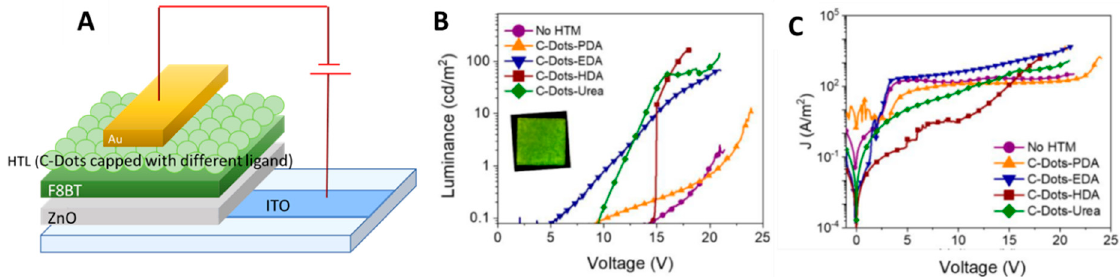
Figure 22. ( A ) Device architecture, ( B ) luminance vs. applied bias (the inset shows a picture of a working device), and ( C ) current density versus applied bias for the inverted LEDs prepared using the CDs in the selective contact for holes: reproduced with permission from Reference [90], copyright 2019 American Chemical Society. Table 2. Summary of the most relevant parameters of devices from Reference [90], including val- ues obtained for a control device without hole transporting layer (HTL).